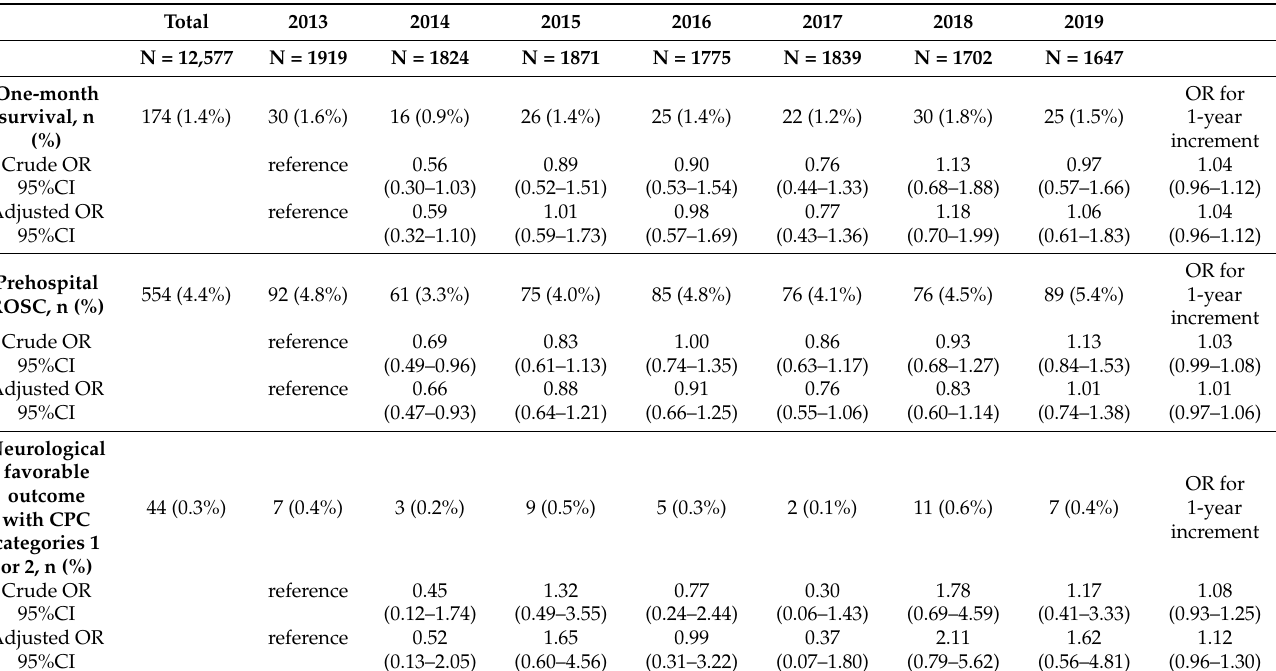
Table 2. Annual trends in the primary and secondary outcomes of traumatic out-of-hospital cardiac arrests after traffic